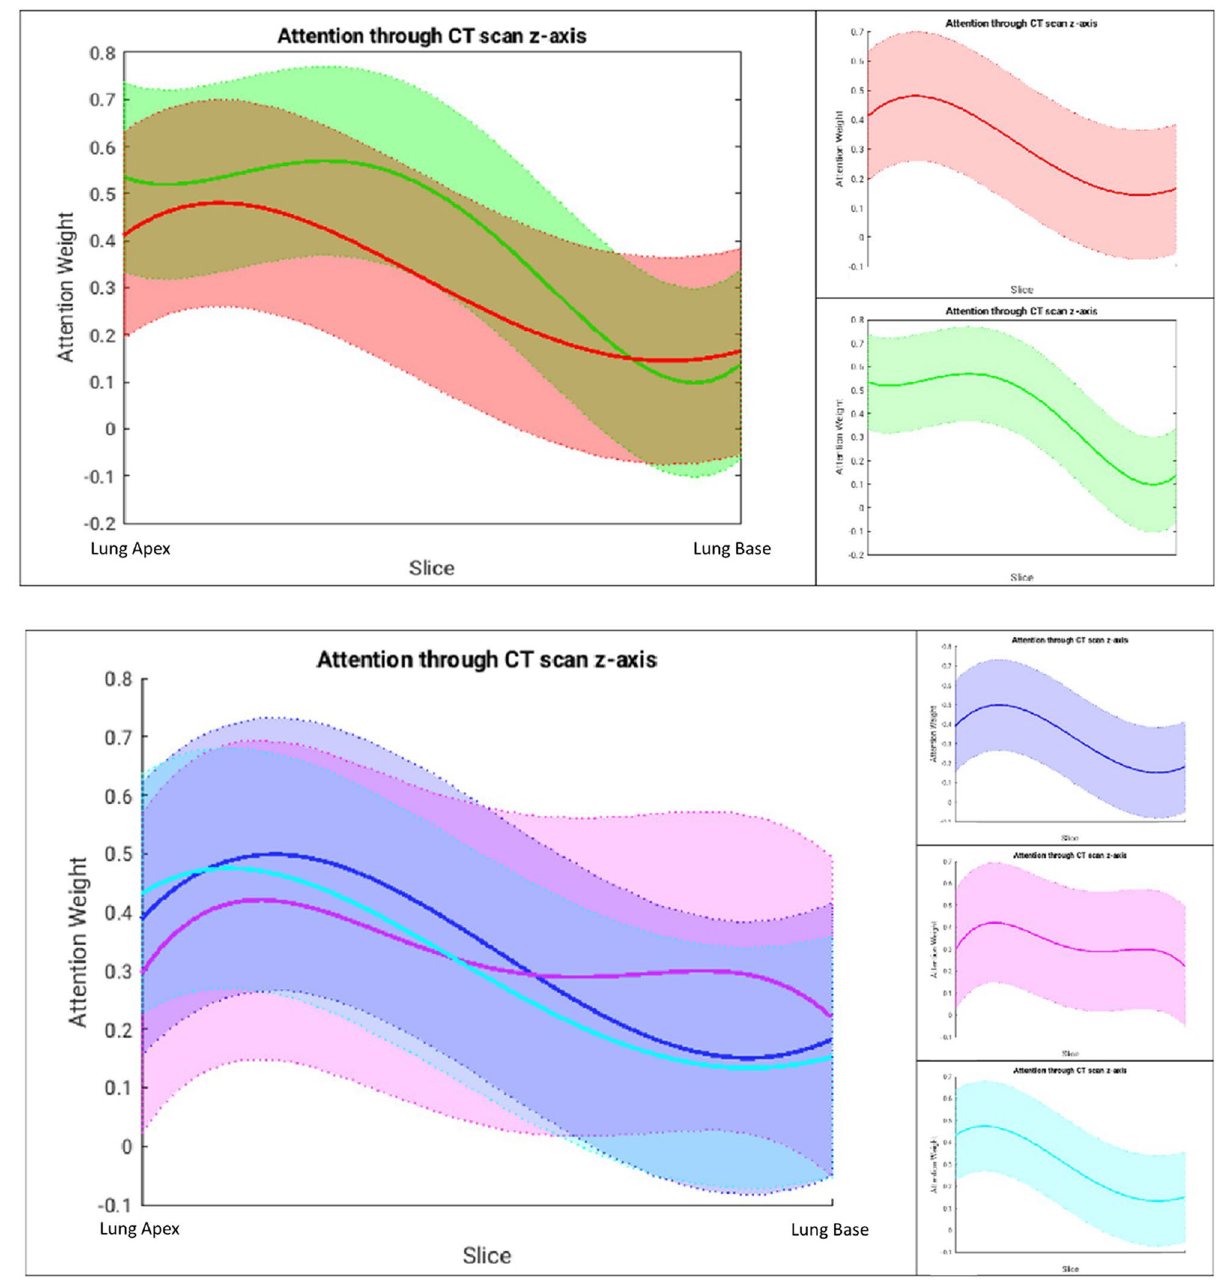
Figure 2. Attention weight curves illustrating the fit of attention weights from CT slices as a function of height in the lungs for (top) positive (red) and negative (green) LDCT scans and (bottom) for different dominant phenotypes of emphysema: centrilobular (blue), panlobular (pink), and paraseptal (turquoise). Since patients’ CT scans have variable number of slices covering the lung region, in these plots, the range has been normalized to fit between Lung Top and Lung